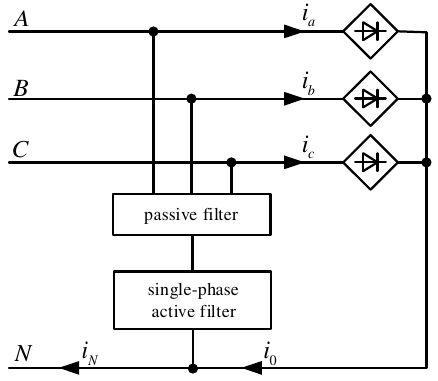
Figure 2. Configuration of hybrid power filter for neutral-line current attenuation.